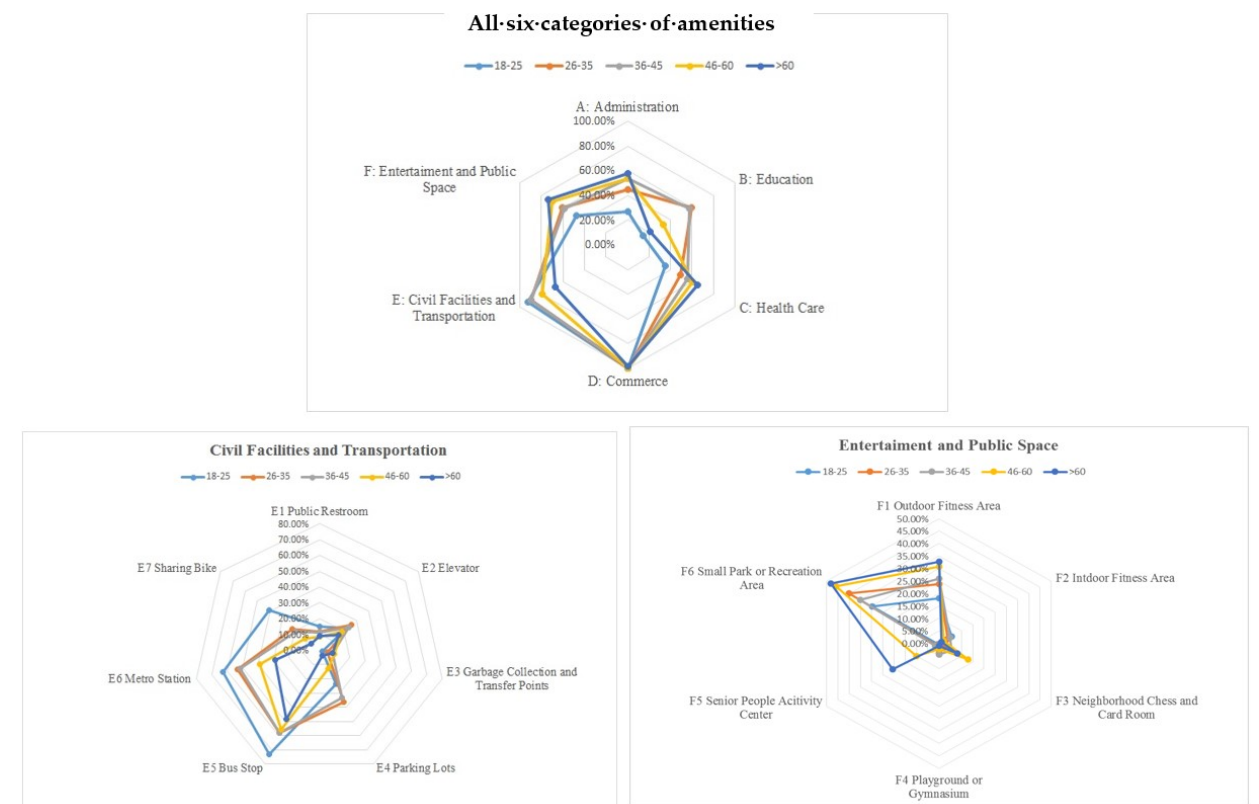
Figure 8. The percentage of frequent users in different age groups.